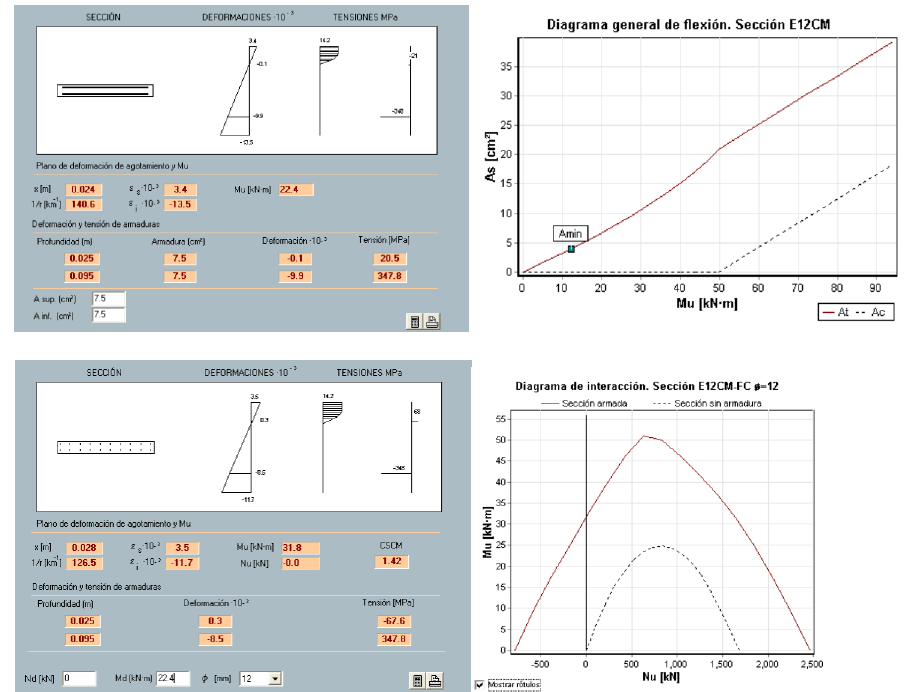
Figure 13. General bending diagram of a 12 cm thick reinforced concrete sheet. Prontuario Inform á tico IECA ( top ). Interaction diagram axial-bending moment of a 12 cm thick reinforced concrete shell. Prontuario Inform á tico IECA ( bottom ).